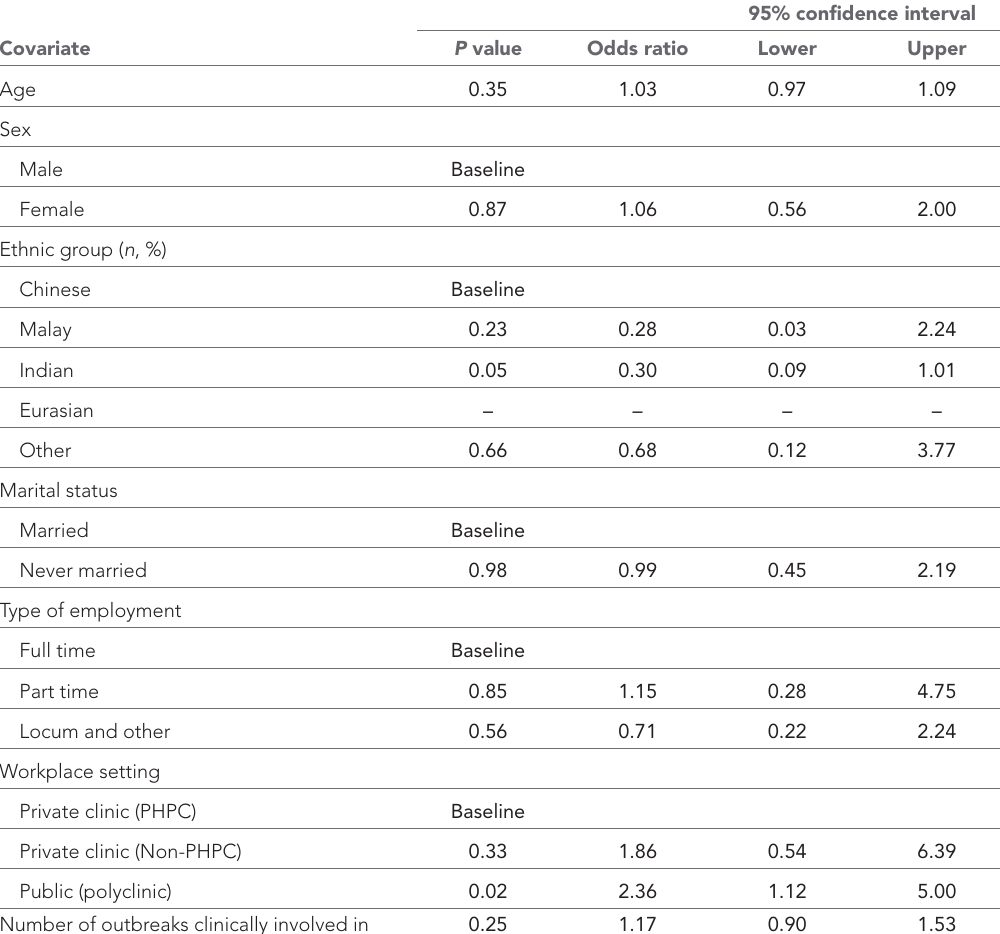
Table 4 Sociodemographic and work environment correlates of depression